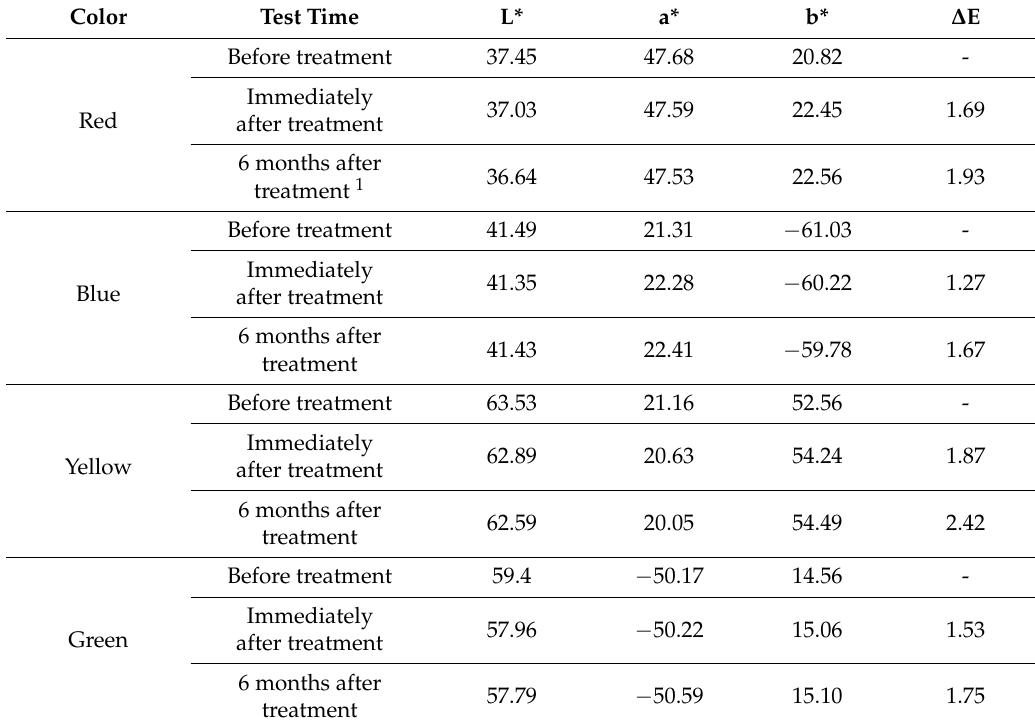
Table 3. Colorimetric change monitoring on different colors after treated by PEOX immediately and after six